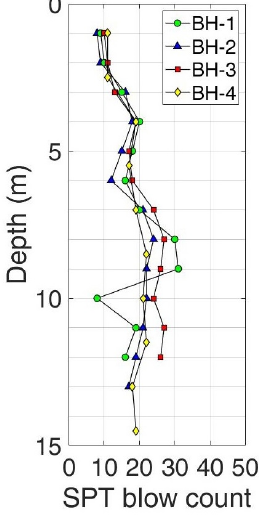
Figure 7. Variation of SPT blow count with depth for BH-1 to BH-4. Table 1. Properties of Saemangeum dredged soil used in the shaking table test. Property